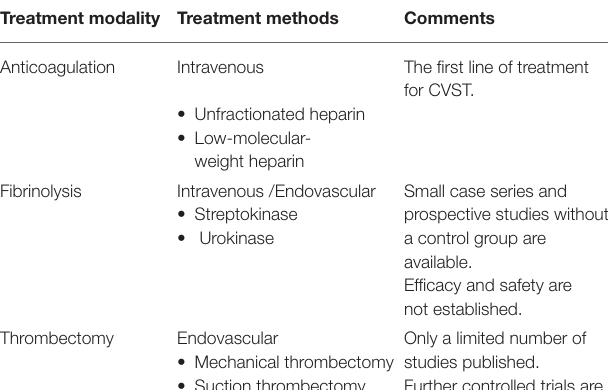
TABLE 2 | Summary of various treatment modalities for